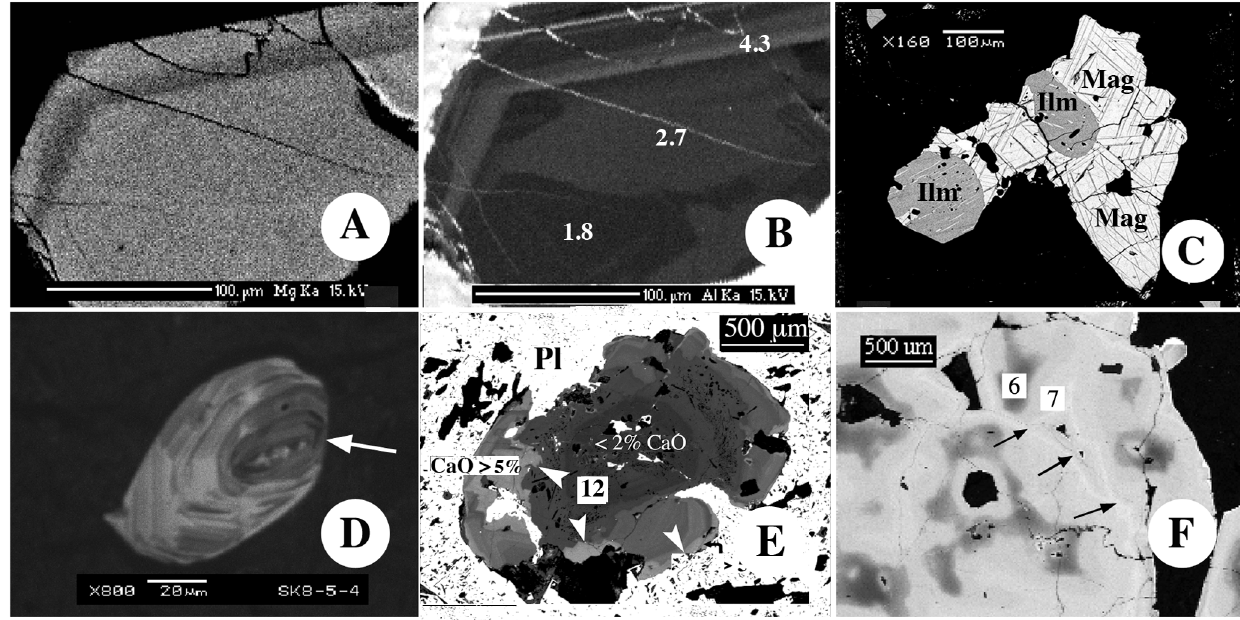
Figure 5: Some details about mineralogy. Mineral abbreviations after Whitney and Evans [2010]. [A] Mg X-Ray SEM image showing euhedral concentric zoning pattern in orthopyroxene. Light grey represents higher, dark grey lower concentration in Mg. [B] In addition to concentric zonation, sector zoning is evidenced by the Al X-Ray image in the core of the orthopyroxene. Numbers correspond to Al O content in wt%. [C] BSE image of coexisting iron- 2 3 titanium oxides. Both minerals exhibit exsolution lamellae expressing intra-oxide reequilibration during cooling (oxidation-exsolution of ilmenite lamellae from titano-magnetite and reduction-exsolution lamellae of magnetite from ilmenite). [D] Cathodoluminescence image of a free zircon in the groundmass showing local magmatic corrosion and rounding of the crystal faces (arrow). [E] EPMA Ca X-Ray map of the metamorphic garnet crystal shown in Figure 3B. A dark grey Ca-poor internal core (CaO < 2 wt%) is clearly visible; it is truncated (white arrows) by the outer magmatic overgrowth (light grey) much richer in Ca (CaO > 5wt%). Number in the white box refers to garnet analysis in Table 6. [F] EPMA Mn X-Ray map of a garnetite inclusion; each garnet crystal is characterised by a Mn-poor core (dark grey), while grain boundaries (arrows) are outlined by much Mn-richer narrow rims (white). Numbered spots in white squares refer to garnet analyses in Table